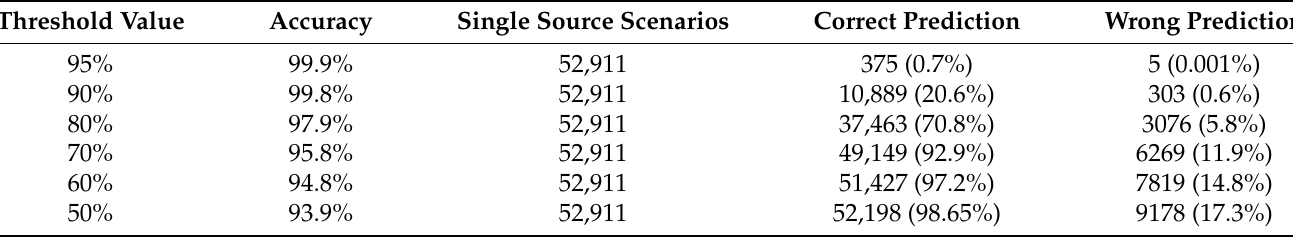
Table 3. Influence of threshold value on model accuracy for Richmond network (250 estimators, maximum depth 30, minimum samples for split 8). Percentage indicates number of predicted simulations based on total number of single source